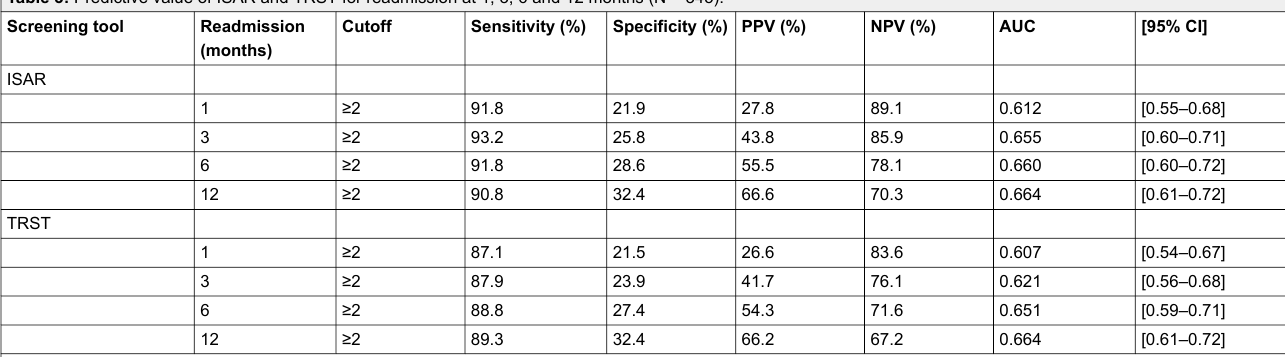
Table 3: Predictive value of ISAR and TRST for readmission at 1, 3, 6 and 12 months (N = 345). Screening